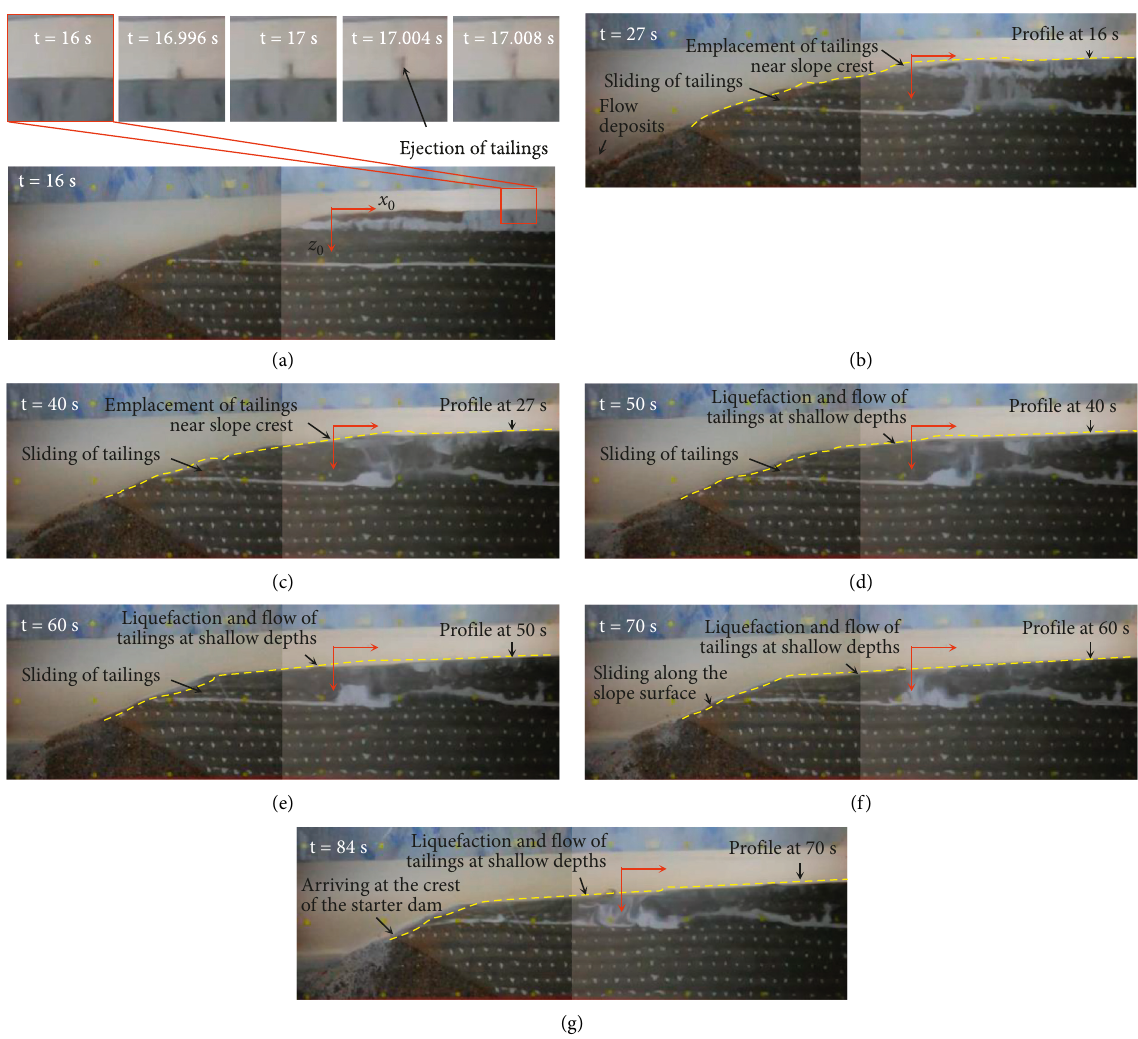
Figure 13: Snapshots of the tailings impoundment during stage 3: (a) t � 16s. (b) t � 27s. (c) t � 40s. (d) t � 50s. (e) t � 60s. (f) t � 70s. (g) t �